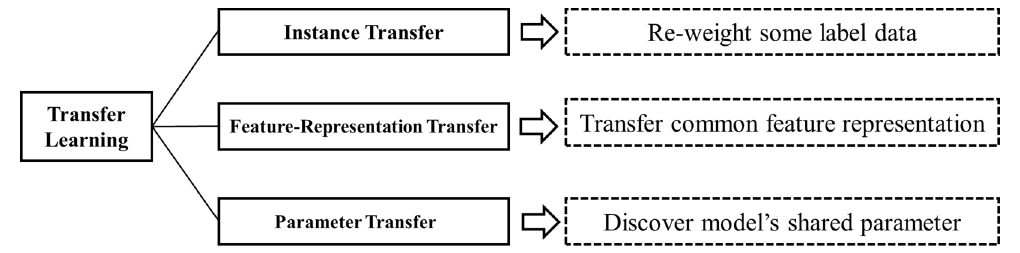
Figure 4. Different approaches to transfer learning. Figure 4. Di ff erent approaches to transfer